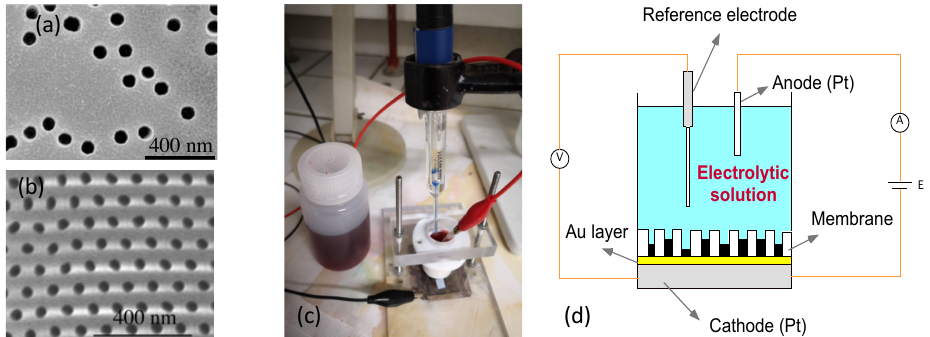
Figure 2. SEM images of ( a ) track-etch polycarbonate membrane and ( b ) porous alumina; ( c ) photograph and ( d ) schematic of the electrodeposition cell used to grow nanowire arrays.